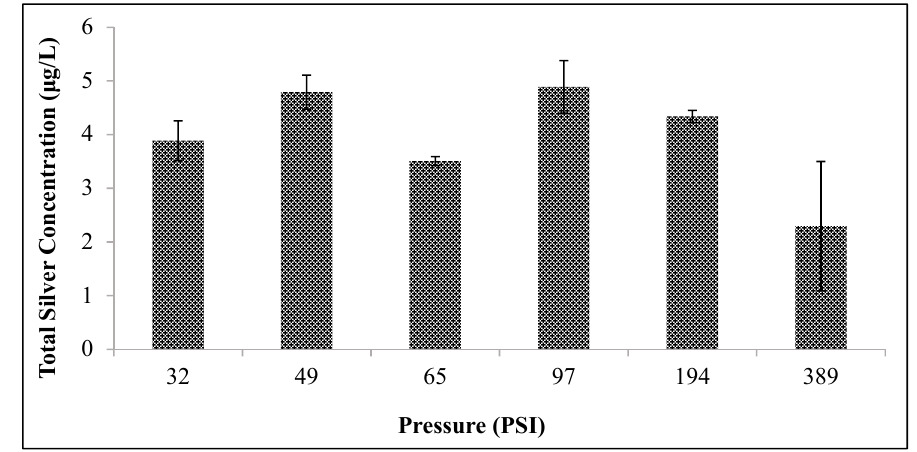
Figure 3. Total silver concentration in 10 L of tap water after 24 h as a function of ceramic tablet compression pressure. Each ceramic tablet contains 1 g of silver. Error bars represent standard error.